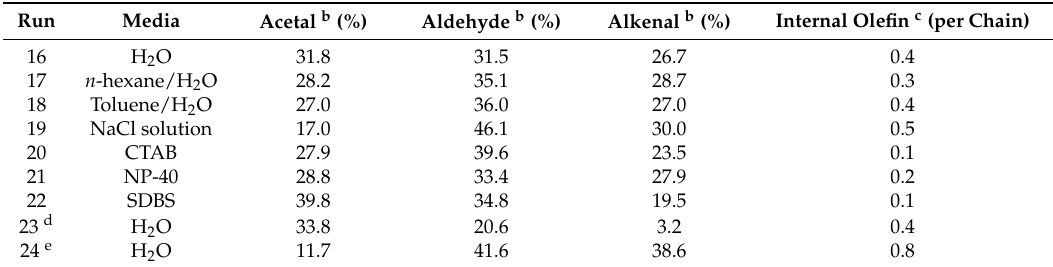
Table 3. Functionality at the ω -end and mid-chain (internal) olefin group content of polymers initiated by CumOH/B(C 6 F 5 ) 3 at 20 ◦ C in aqueous media.